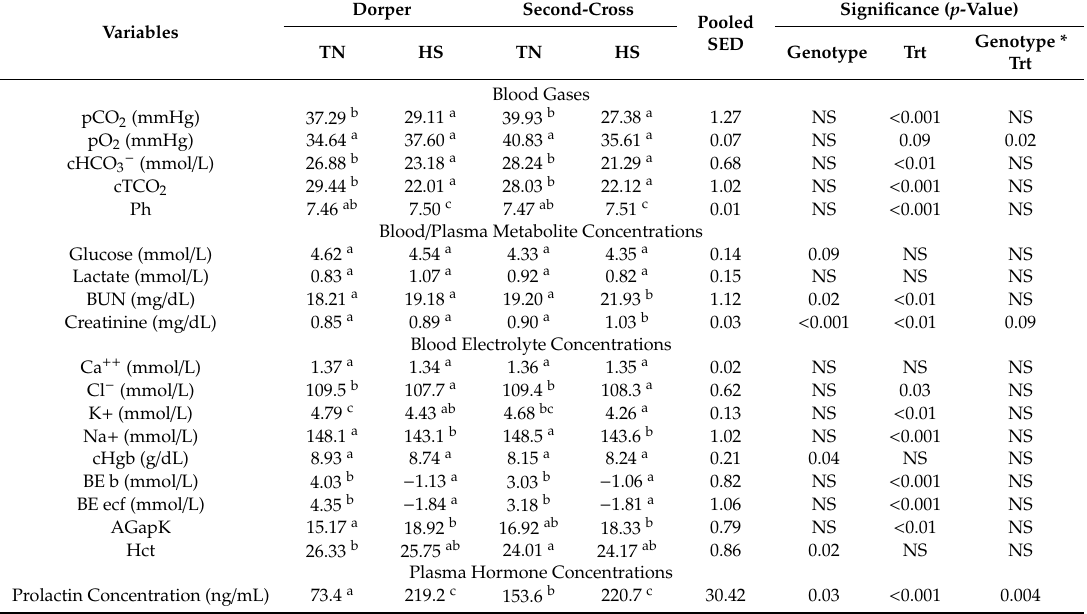
Table 3. Mean ( ± SED) values for blood gases, metabolites and electrolytes in blood in Dorper and SC lambs under TN or HS conditions for 14 days ( n = 12 /